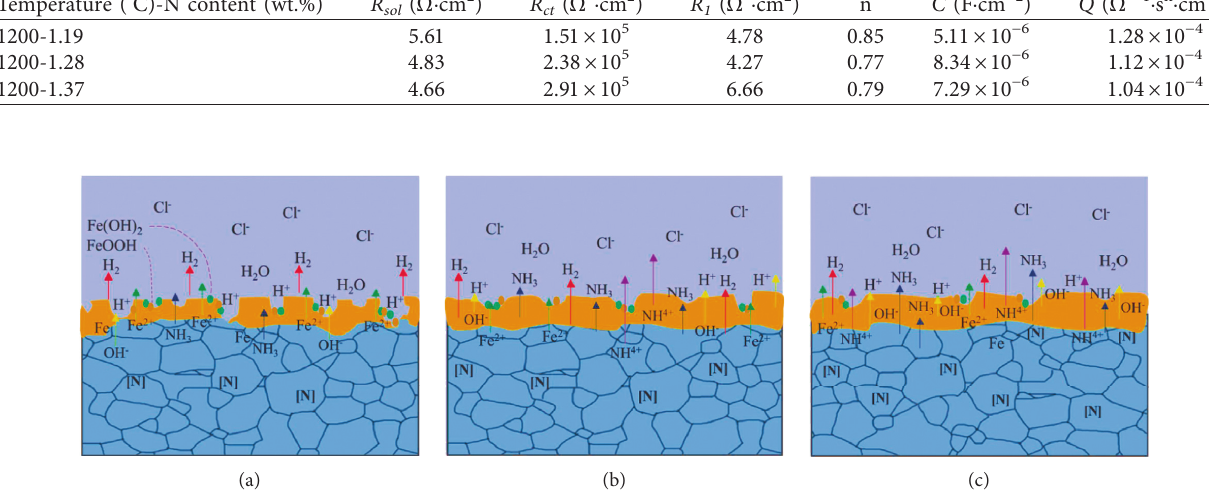
Figure 9: Schematic for the corrosion of the HNNS samples with (a) 1.19 wt.% (N), (b) 1.28 wt.% (N), and (c) 1.37 wt.%